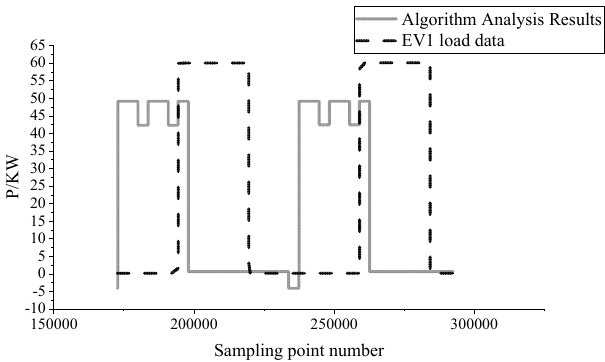
Figure 6. Decomposition result of EV1 of electric vehicle charging station with no new random load by deep neural network.